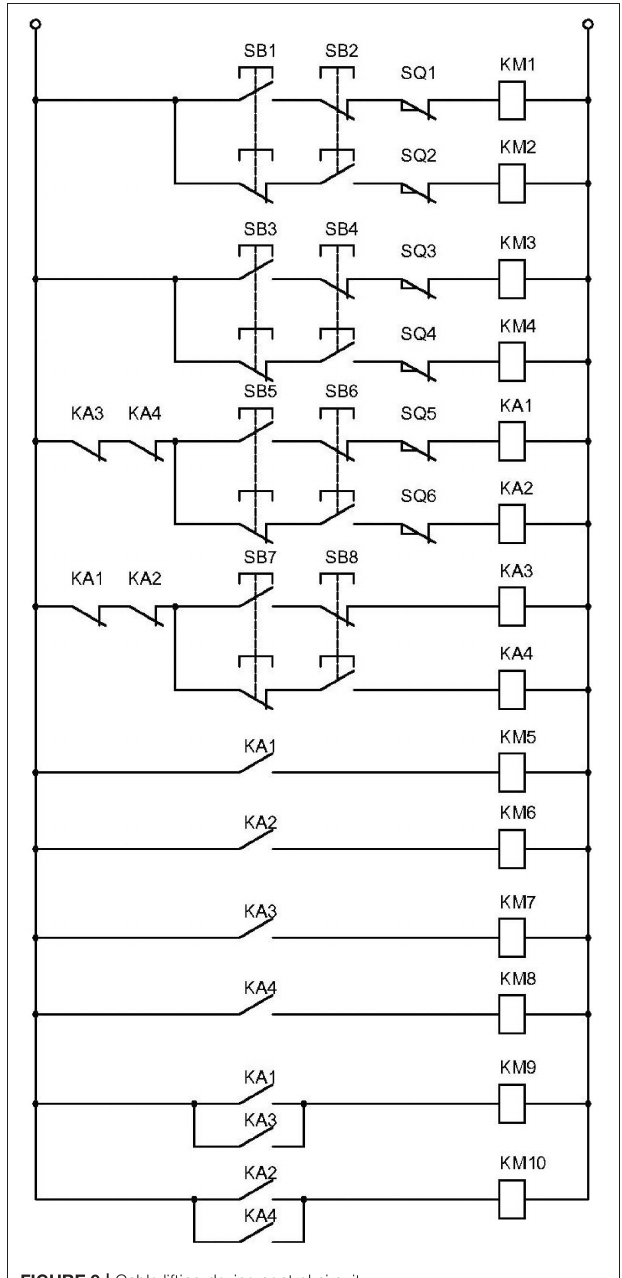
FIGURE 9 | Cable lifting device control